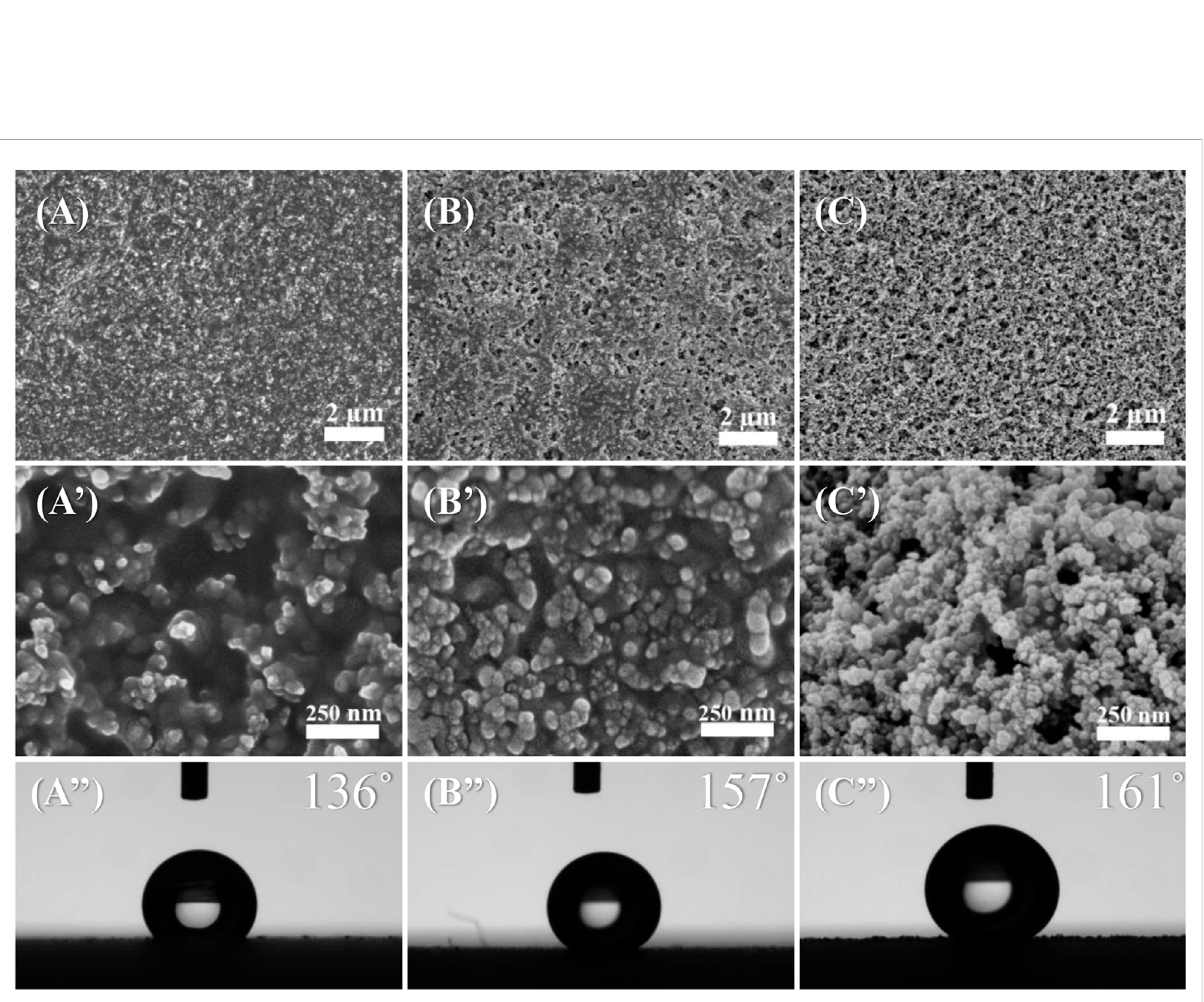
FIGURE 3 SEM images at different magni fi cations and WCAs of acrylate copolymer/0.15-SiO 2 NPs coating (A,A 9 ,A ’’ ) , acrylate copolymer/0.25-SiO 2 NPs coating (B,B 9 ,B ’’ ) , and acrylate copolymer/0.35-SiO 2 NPs coating (C,C 9 ,C ’’ )